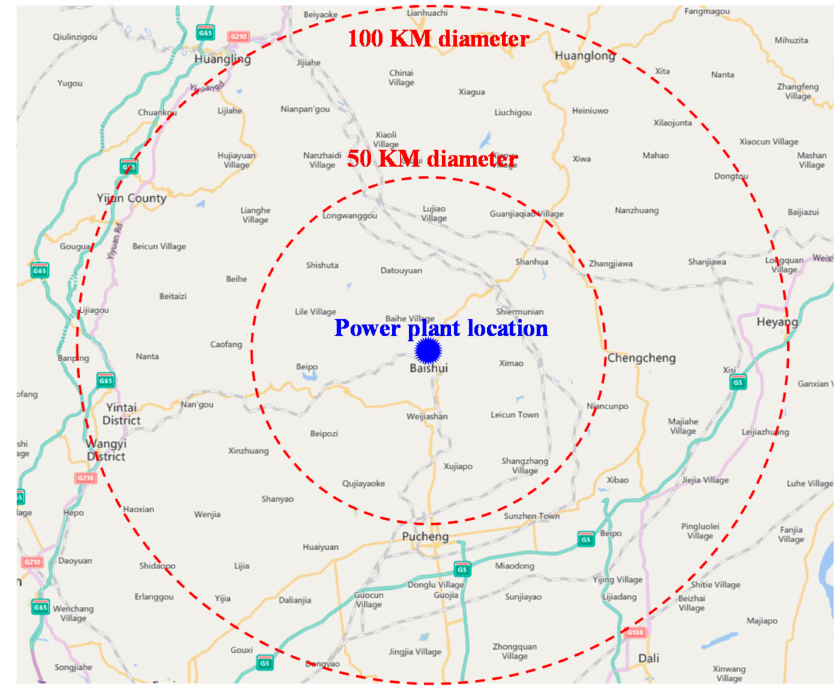
Figure 1. Power plant location and biomass collection